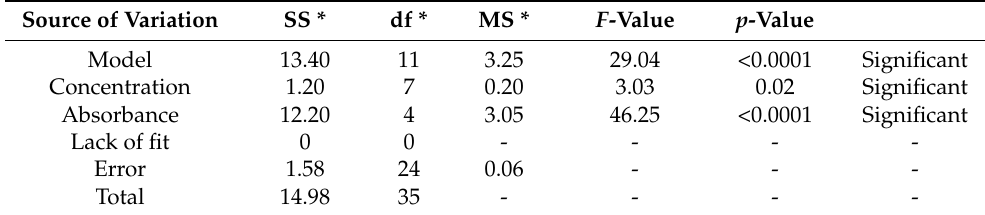
Table 8. ANOVA table of the minimum concentration for eradication of biofilm for MWCNTs_HAp on the investigated strains.